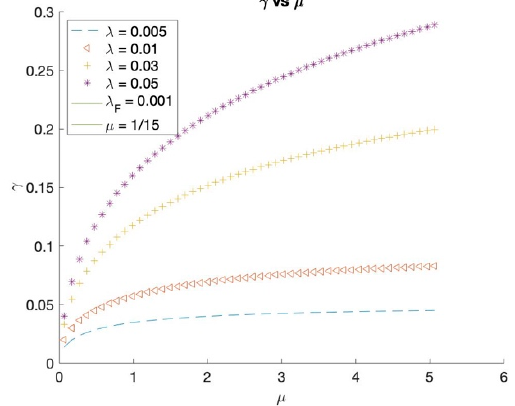
Figure 9. Throughput per block ( γ ) vs number of slots ( n ).